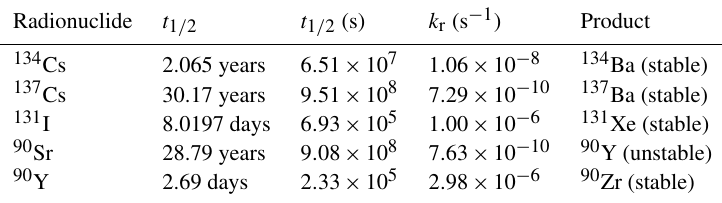
Table 6. List of radionuclides implemented in the model. Table shows half life, decay rate (in s − 1 ) and resulting child product.